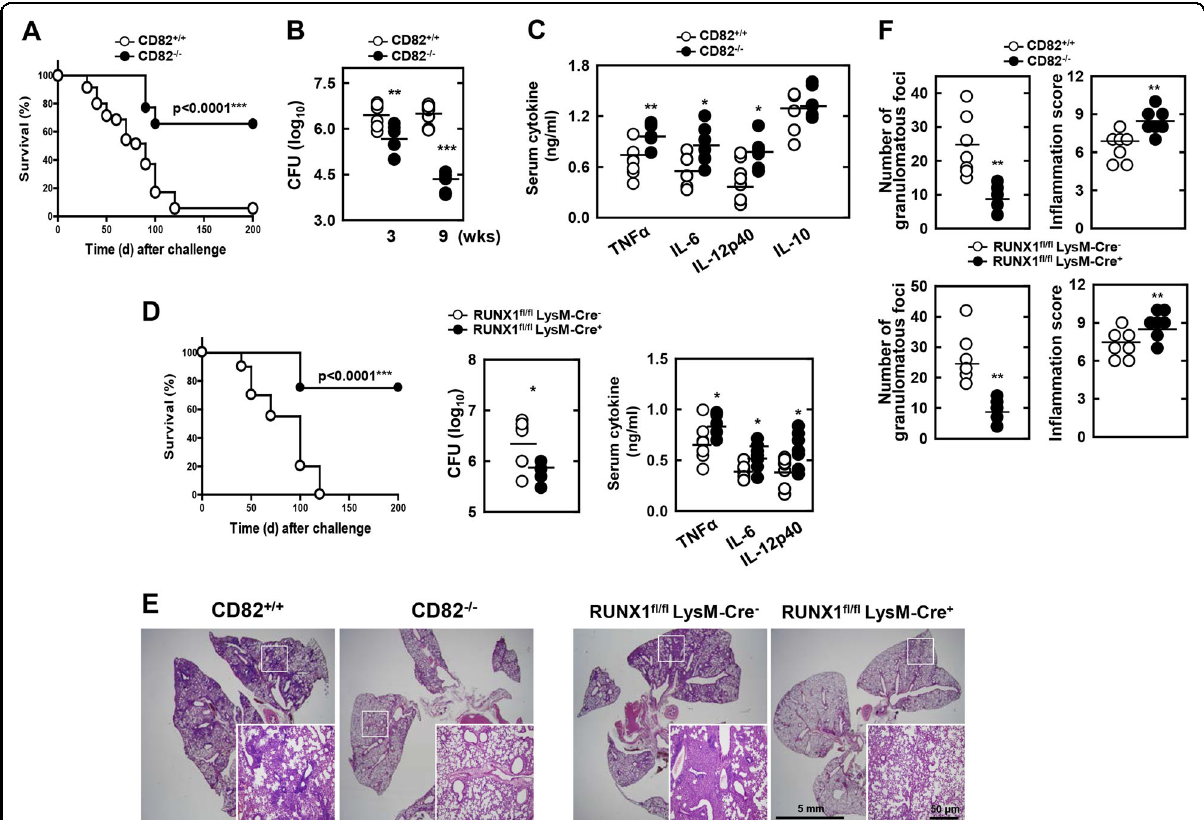
Fig. 7 Modulation of CD82 and RUNX1 affects TB pathogenesis after MTB infection. a , d Survival of ( a ) CD82 + / + and CD82 − / − mice ( n = 35) or ( d ) RUNX1 fl / fl LysM-Cre + and RUNX1 fl / fl LysM-Cre- mice ( n = 20) infected with a high intravenous dose (1 × 10 8 CFUs per mouse) of MTB Rv and monitored for 200 days. Signi fi cant differences in comparison to the control mice are indicated (log-rank test). b – f CD82 + / + and CD82 − / − or RUNX1 fl / fl LysM-Cre + and RUNX1 fl / fl LysM-Cre- mice were infected with an intranasal dose (1 × 10 3 CFUs per mouse) of MTB Rv. b , d Bacterial loads in lungs and c , d serum cytokine levels were determined at 3 weeks; n = 7. e Histopathology scores were obtained from H&E-stained lung sections at 3 weeks, as described in the Methods. Insets, enlargement of outlined areas. f Number of granulomas and in fl ammation scores observed in seven different lung sections per mouse. Black bars represent the median values. Student ’ s t -test and Grubbs ’ outlier test were used for statistical analysis. The data are representative of two independent experiments with similar results. Signi fi cant differences (* P < 0.05; ** P < 0.01; *** P < 0.001) compared with CD82 + / + and RUNX1 fl / fl LysM-Cre- (Student ’ s t- test with Bonferroni adjustment). CFU colony-forming